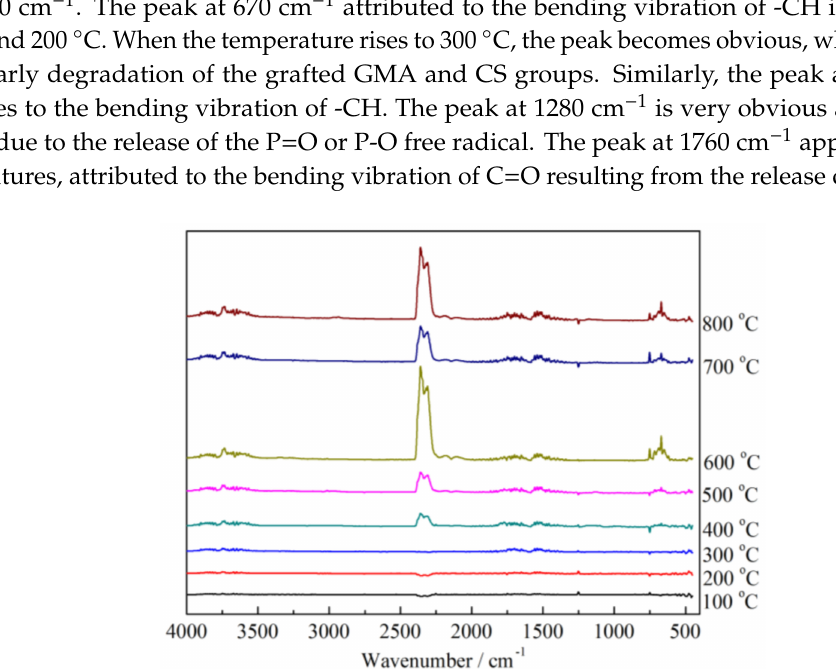
Figure 5. FTIR spectra of FR-PAN under di ff erent decomposition